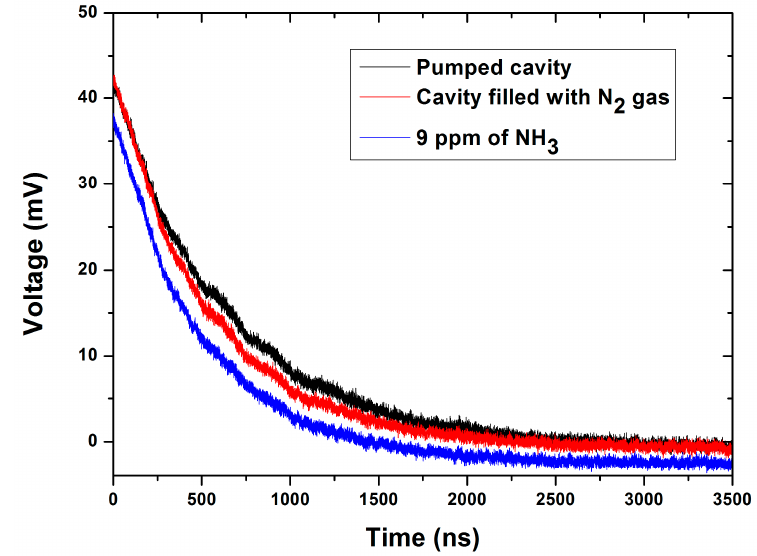
Figure 5. CRD decays recorded for the pumped, nitrogen filled and 9 ppm concentration of ammonia at wavenumber of 1469.852 cm − 1 .